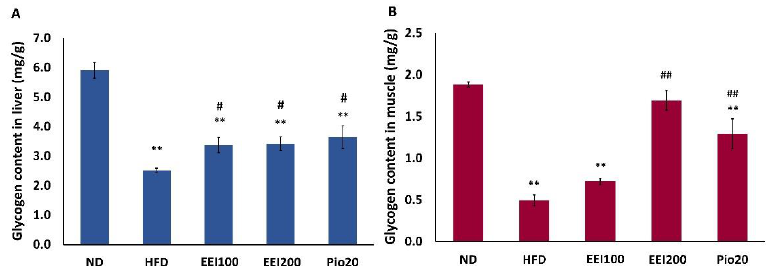
Figure 2. The effect of 2-week feeding EEI on glycogen content in the liver ( A ) and soleus muscle ( B ). Results are presented as the means ± SEM ( n = 10). Significant differences were presented